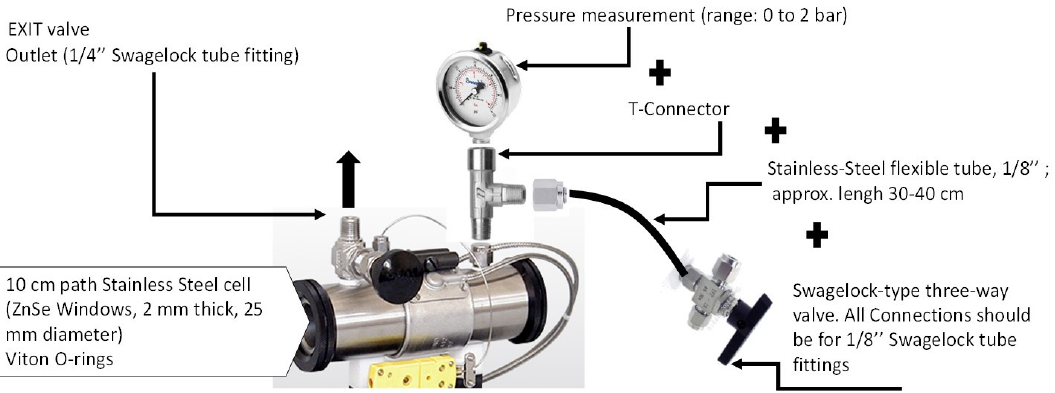
Figure 2. Comparison of spectra obtained using a multireflection gas cell (1 m pathlength) with CaF 2 windows (yellow) and a single-pass gas cell (10 cm) with ZnSe windows. The region in the box shows the influence of the windows (see text for details).